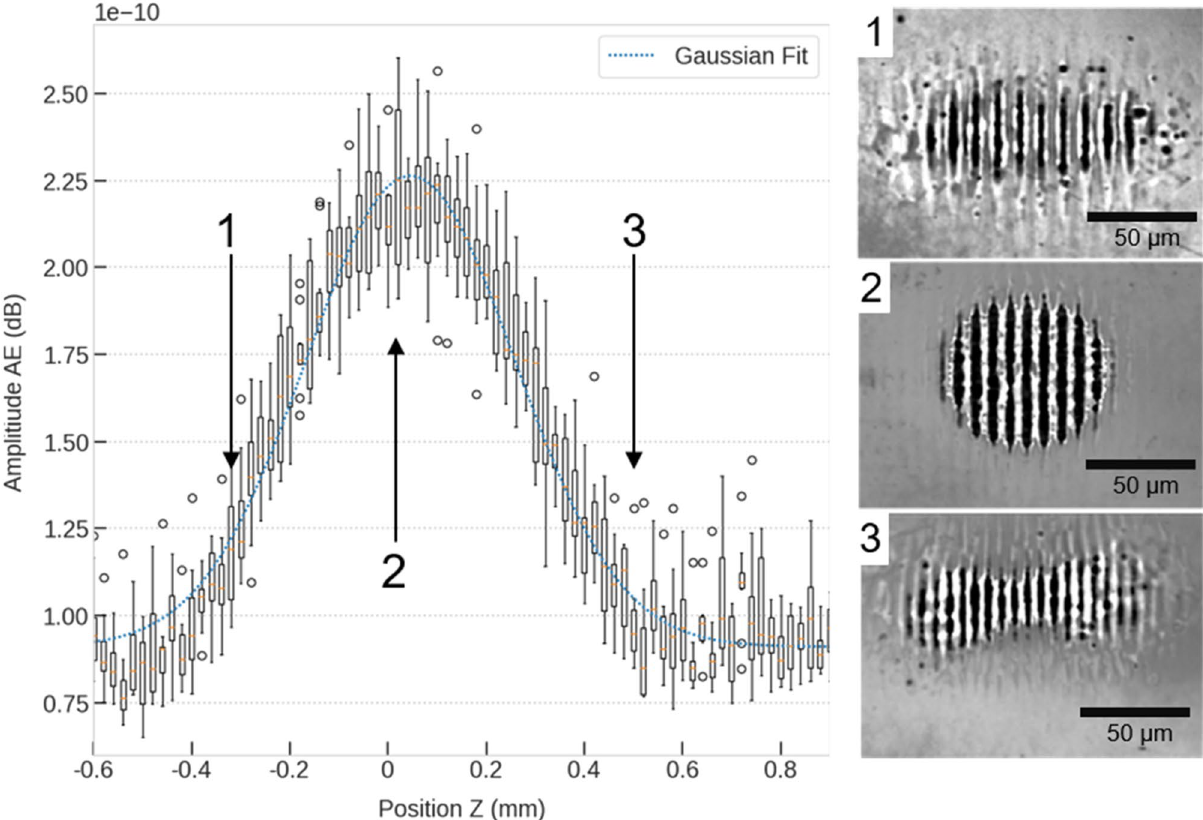
Figure 3. Absolute maximum sound pressure level during DLIP processing for varying z distance. The optimum working position of the interference volume is 36.15 mm.